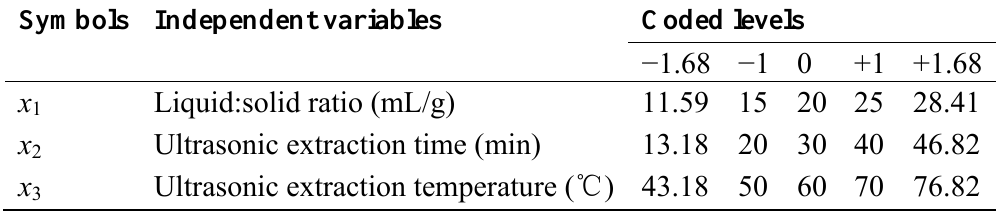
Table 5. Uncoded and coded levels of independent variables used in the RSM design.